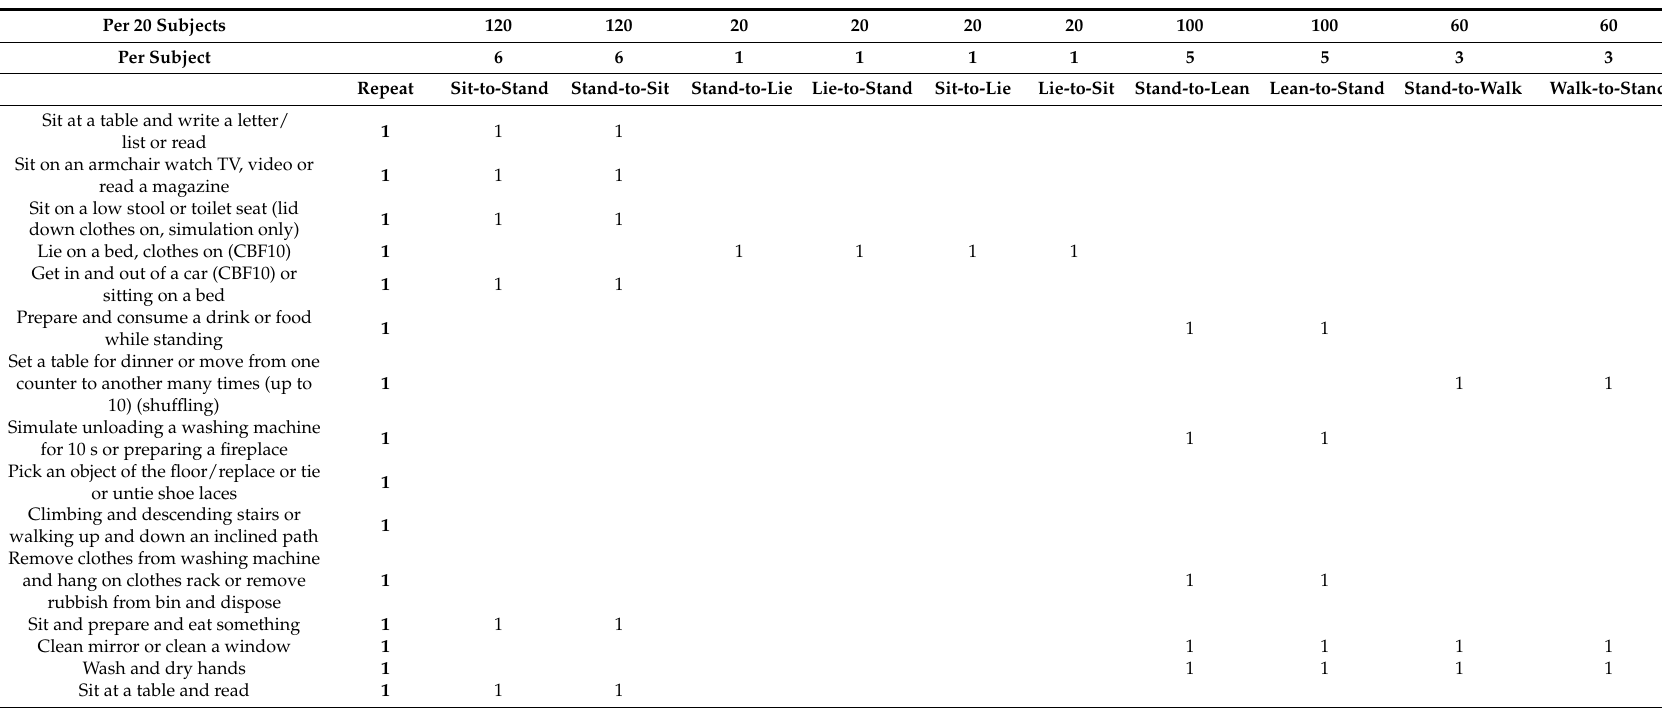
Table A2. Postures, transitions and behaviours for the free-living protocol for each task on a per subject basis and for a total of 20 subjects, assuming each task is repeated